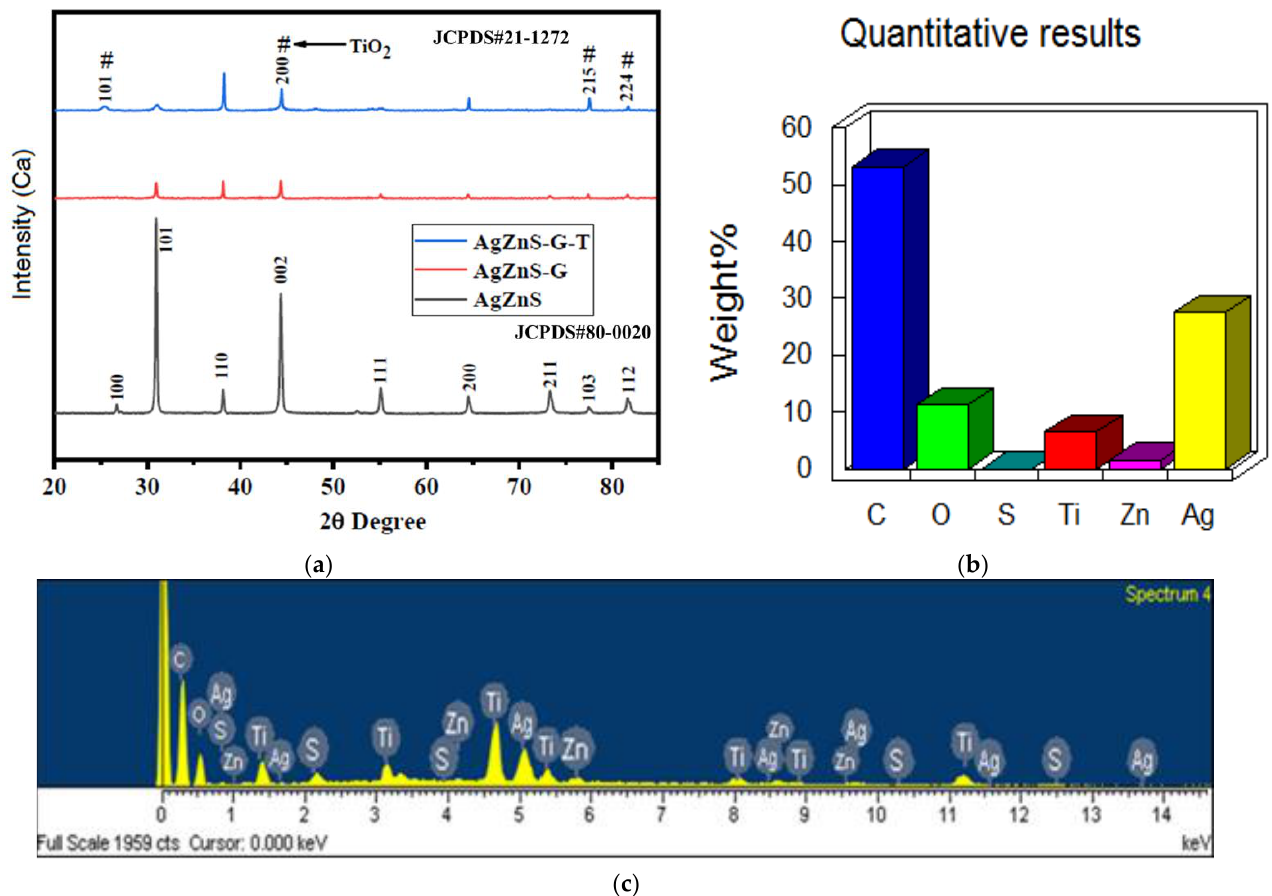
Figure 1. ( a ) XRD patterns of AgZnS, AgZnS-G, and AgZnS-G-T; ( b ) and ( c ) EDX spectra of AgZnS-G-T photocatalysts.